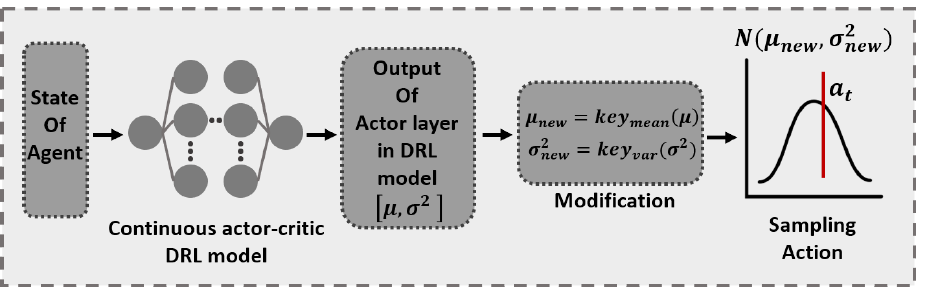
Figure 3. Sampling process of action for the proposed deep reinforcement learning (DRL)